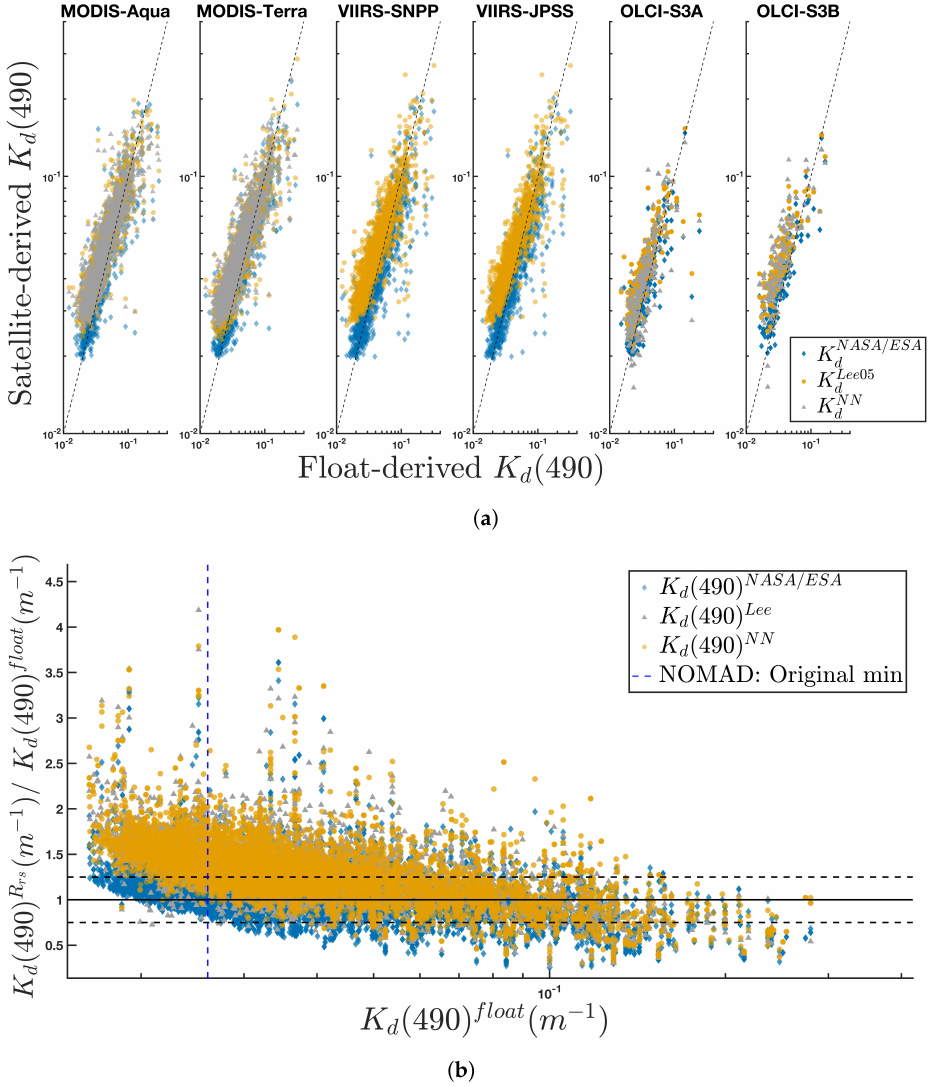
Figure 3. Comparison of satellite-derived and float-derived K d ( 490 ) for the MODIS-Aqua, MODIS- ( 490 ) computed us- Terra, VIIRS-JPSS, VIIRS-SNPP, OLCI-S3A and OLCI-S3B sensors: ( a ) K R rs d ( 490 ) ; the black dashed line is the 1:1 line; ing the 3 different algorithms compared to K float d ( 490 ) / K float ( 490 ) for each of the 3 evaluated algorithms (color coded) for all sensors; the ( b ) K R rs d d solid black line is a ratio of 1, and the dashed black lines are the 0.75 (Bottom) and 1.25 (Top) ra- tio. The vertical dashed blue line indicates the minimum value of K d ( 490 ) present in the NOMAD dataset